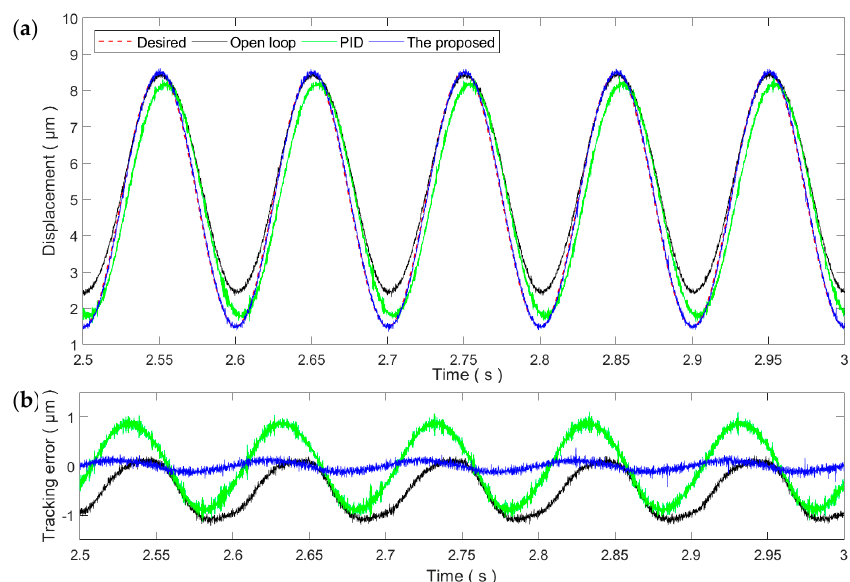
Table 1. Tracking errors of proportional-integral-derivative (PID) and the proposed approach. Figure 6. Tracking of the 10 Hz sinusoidal trajectory: ( a ) Time plot and ( b ) tracking